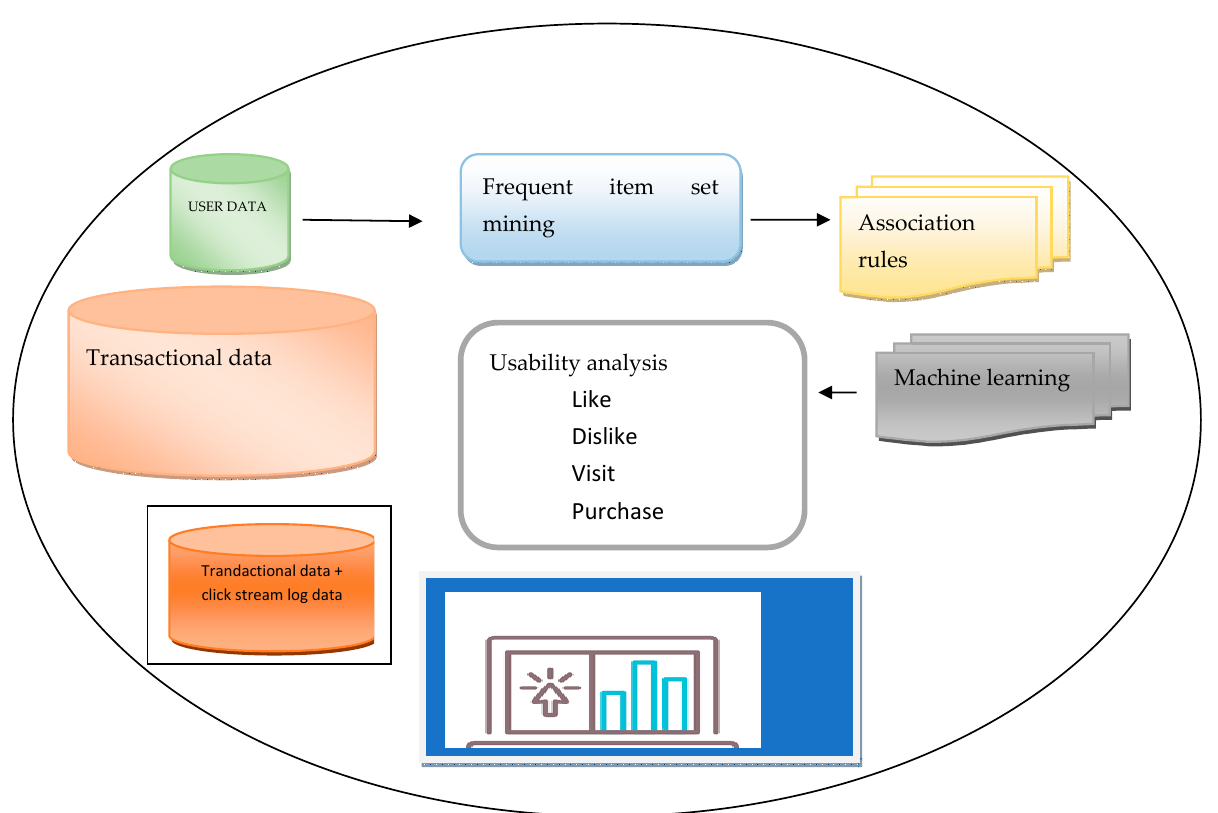
Figure 2. Component of e-commerce usability using machine learning and association rule mining.